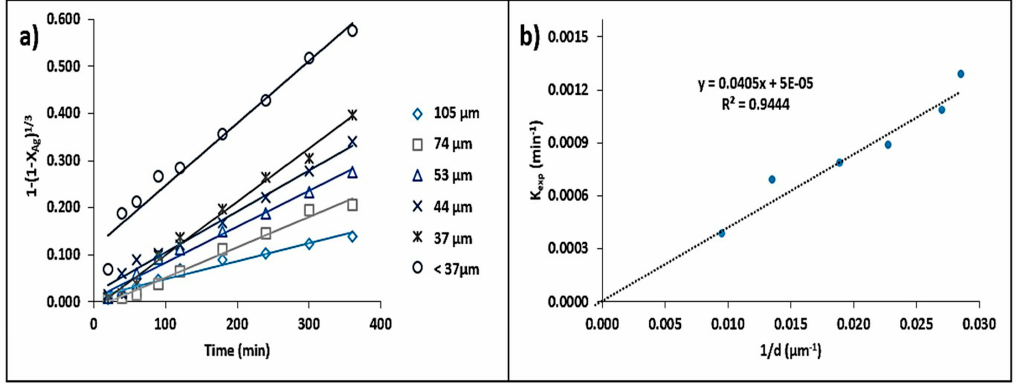
Figure 7. ( a ) Evaluation of the chemical control model on the Ag conversion values as a function of time in order to study the particle size effect. V = 0.5 L, Mineral = 40 g ∙ L − 1 , P O2 = 1 atm, pH = 9, t r = 360 min, [S 2 O 32 − ] = 0.5 mol ∙ L − 1 , [OH − ] = 0.1 mol ∙ L − 1 , 298 K, RPM = 670 min − 1 . ( b ) Dependence of k exp as a function of the inverse of the particle diameter.